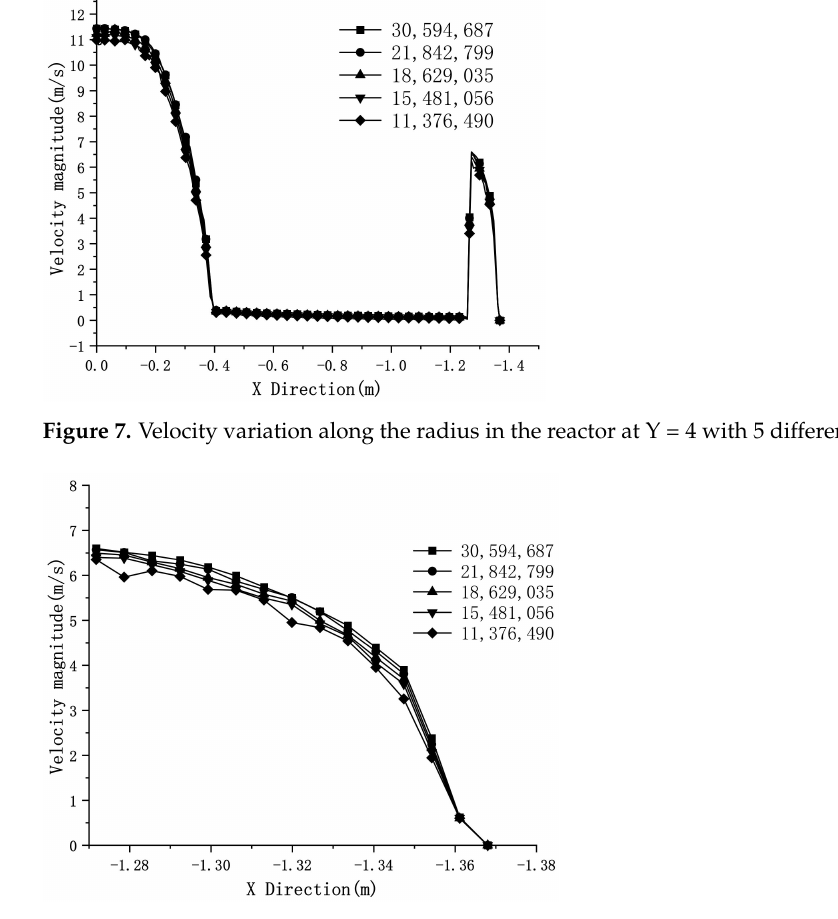
Figure 8. Annular channel velocity variation alone for the bed length for five mesh